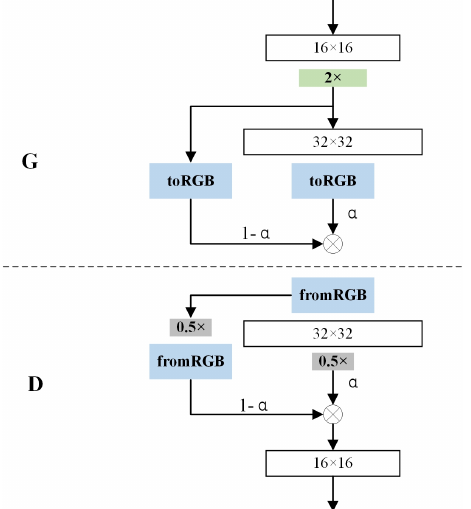
Figure 7. New layer